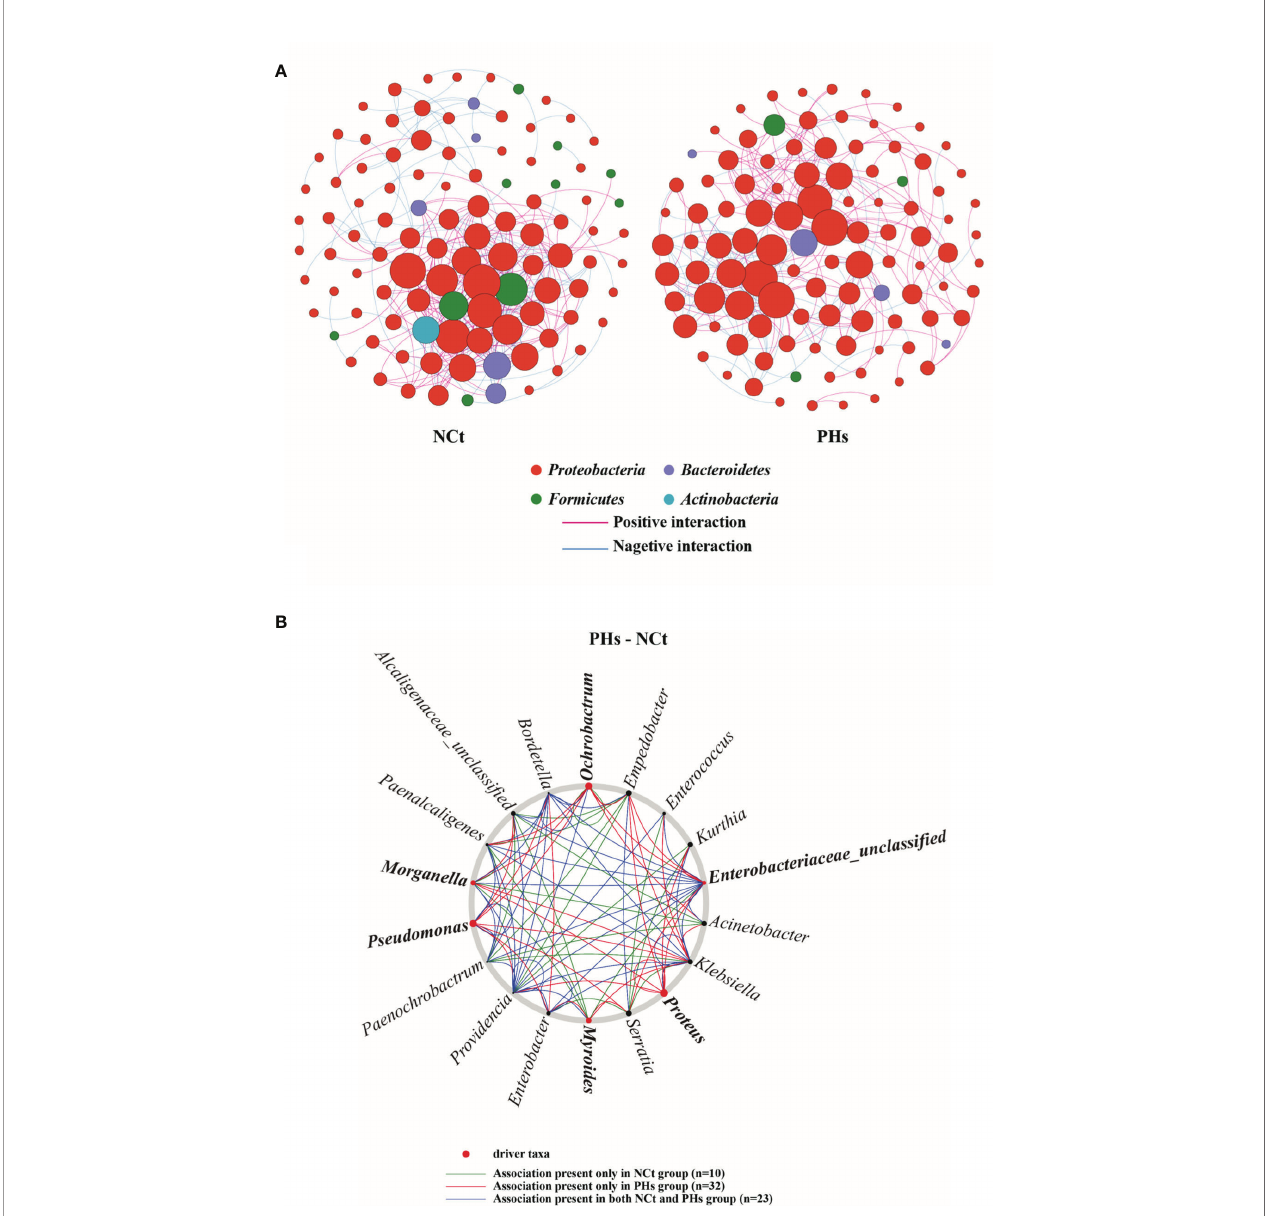
FIGURE 8 | Intestinal bacterial co-occurrence microbiome networks of the NCt and PHs groups. (A) Effects of single phages on bacterial co-occurrence networks. Bacterial co-occurrence networks associated with single-phage experiments. Each node represents a bacterial OTU, and each edge represents a negative (displayed in blue) or positive correlation (displayed in red). The node colors represent taxon classi fi cations at the phylum level. (B) Based on a NetShift analysis of the NCt and PHs groups, the potential driver taxa are essential for observing the bacterial changes in correlated network co-occurrences after phage treatment and are marked PHs-NCt. Each node size is proportional to its NESH (neighbor shift) score (a score identifying the importance of a given microbial taxon in the association network), and the nodes colored red are important driver taxa. As a result, the large red nodes represent driver taxa that are particularly important during phage infection. The line colors indicate node (taxa) connections as follows: the association appears in only the case groups (red edge), the association appears in only the control groups (green edge), and the association appears in both the case groups and the control groups (blue